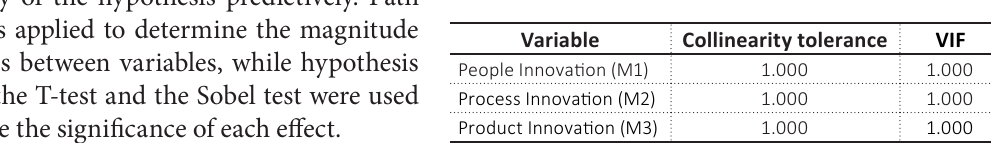
Table 4. Multicollinearity test for the 1 st